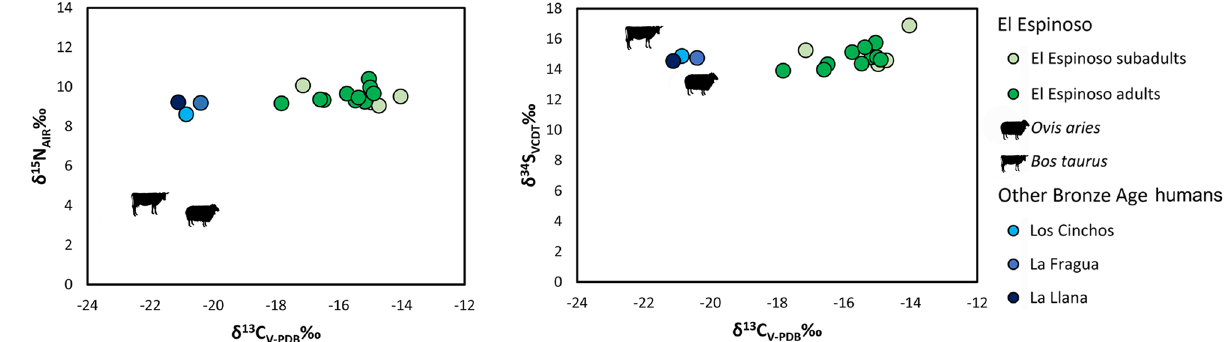
Figure 3. Scatterplot of human and animal bone collagen δ 13 C, δ 15 N and δ 34 S values of El Espinoso cave and